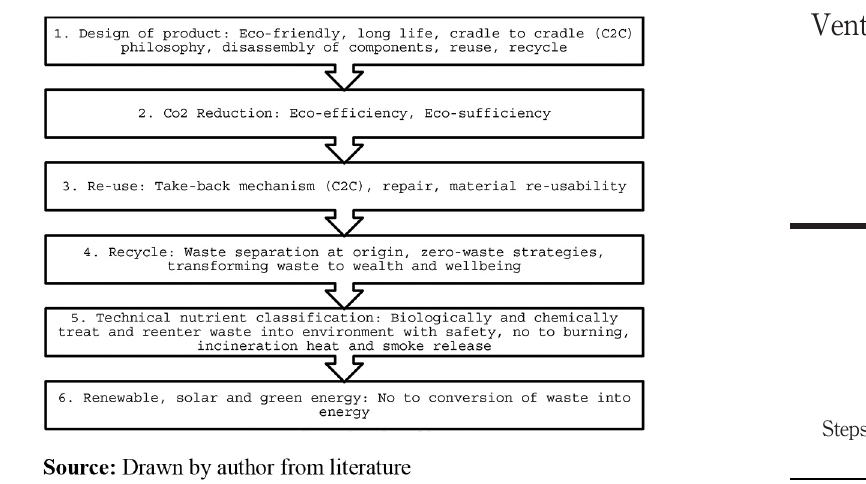
Figure 6. Steps to